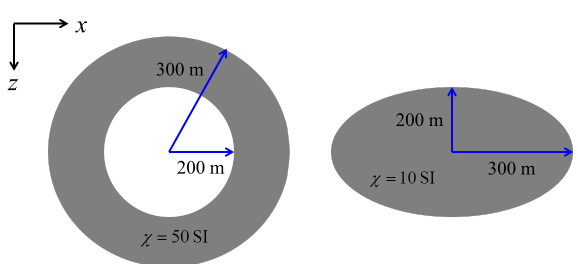
Figure 4. The magnetic spherical shell model with susceptibility of 50 SI and the prolate ellipsoid model with susceptibility of 10 SI used in the accuracy